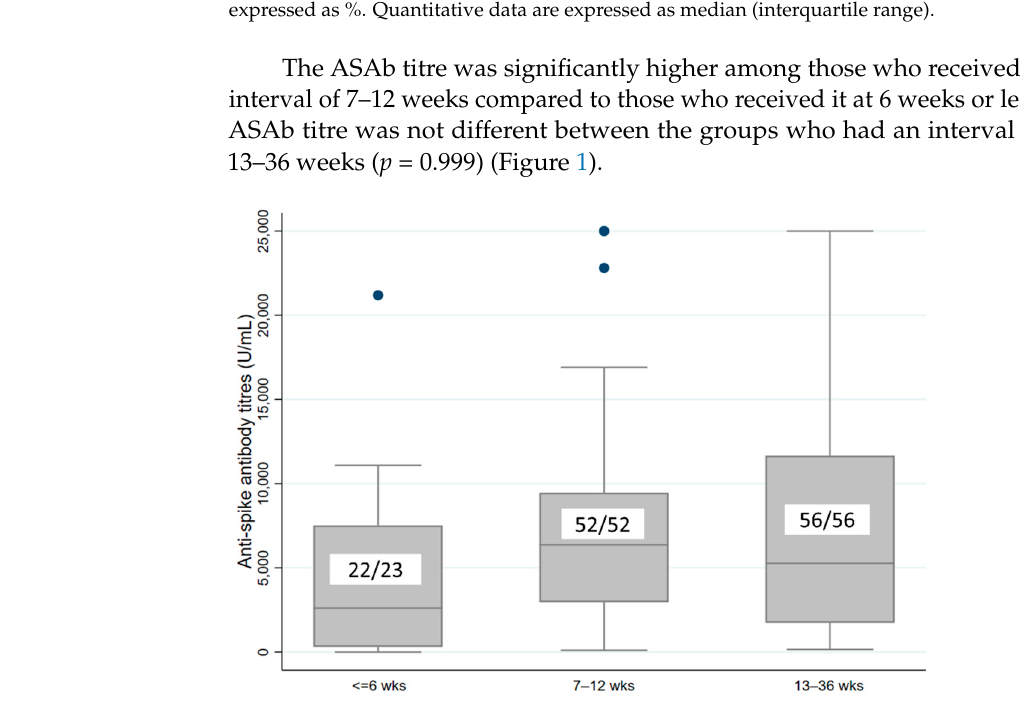
Figure 2. Boxplot comparing the COVID-19 neutralizing antibody percentage between the partici- pants who received two doses of vaccine at different intervals.